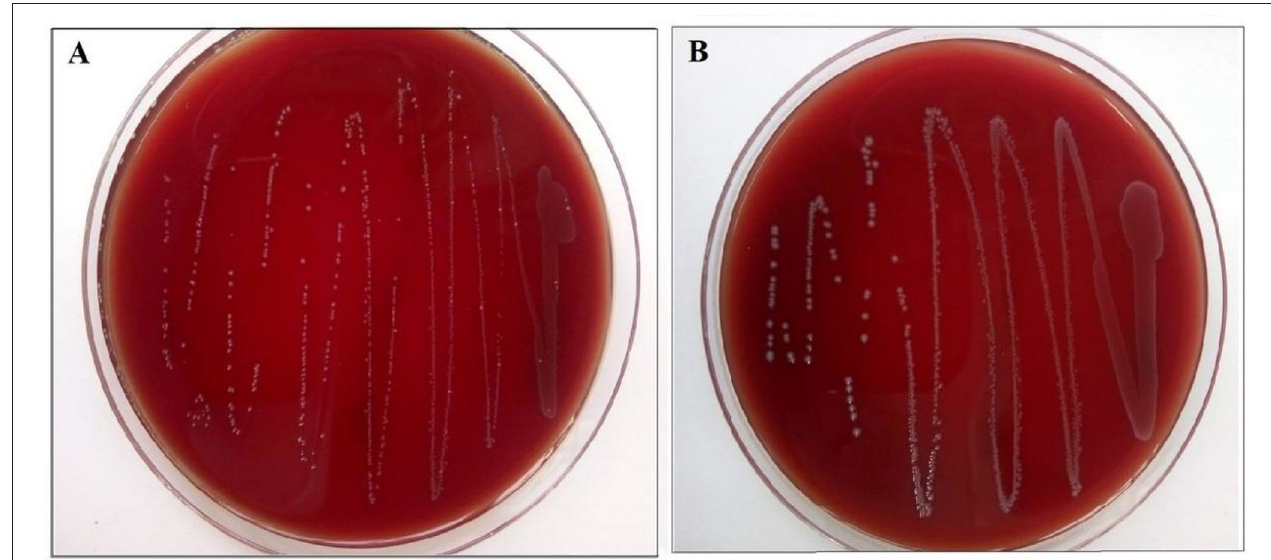
TABLE 6 | Bodyweight, weight gain, and feed intake of rats fed with experimental diets (mean values, n = 6).